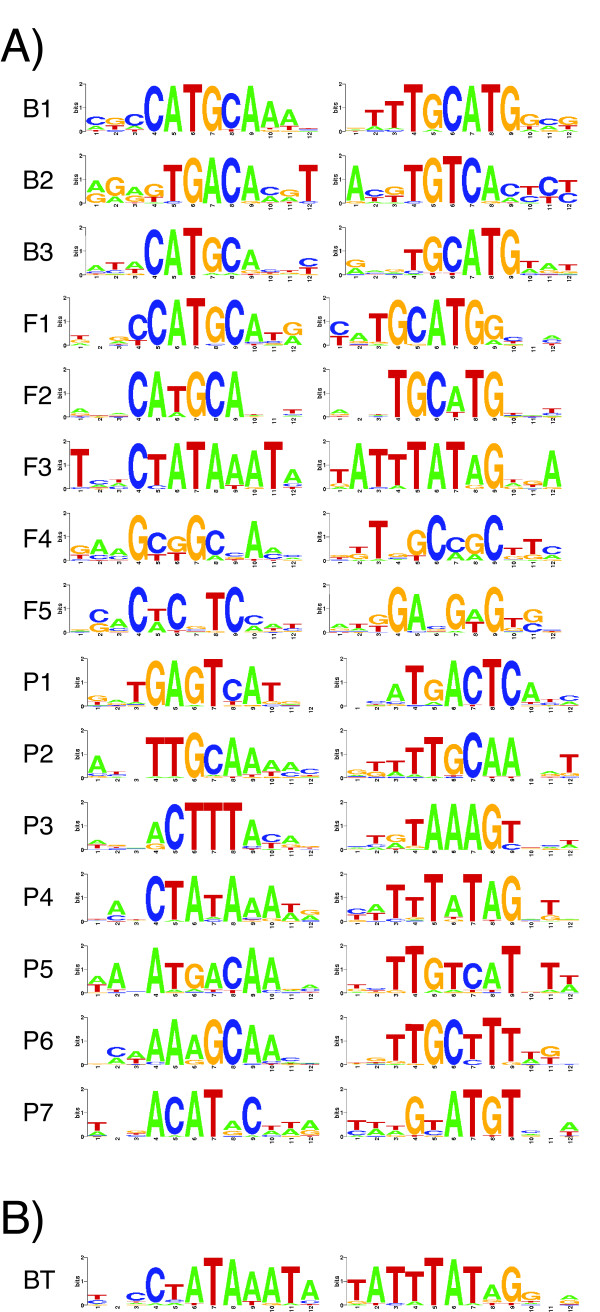
Sequence logos of motifs enriched in seed storage protein gene promoter sequences. A) Sequence logos of significant DNA motifs discovered in SSP gene promoter sequence from Brassicaceae (B1-3), Fabaceae (F1-5) and Poaceae (P1-P7). B) Sequence logos of the TATA-box motif identified in Brassicaceae SSP gene promoter sequences. Left, forward motif, right, reverse complement of motif.